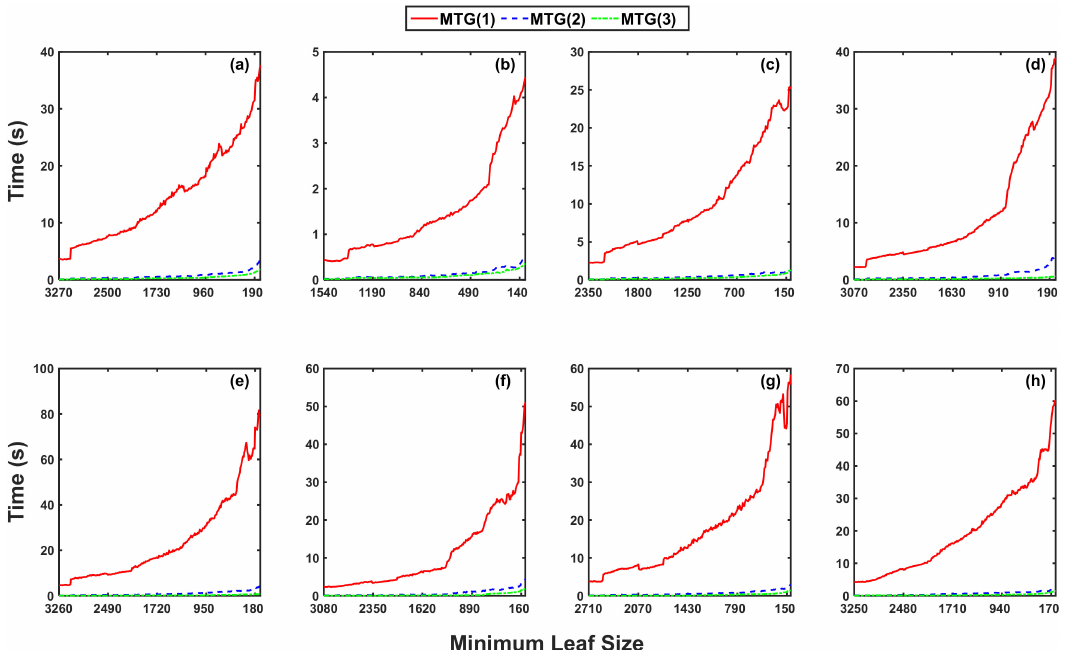
Figure 13. The induction time of models against minimum leaf size in descending order for; ( a ) Arkabutla, ( b ) Coralville, ( c ) Dale Hollow, ( d ) Eldorado, ( e ) Folsom, ( f ) Prado, ( g ) Shasta and ( h ) Trinity reservoirs for MTG(1), MTG(2), and MTG(3) on Dell XPS 8910 with core i7-6700